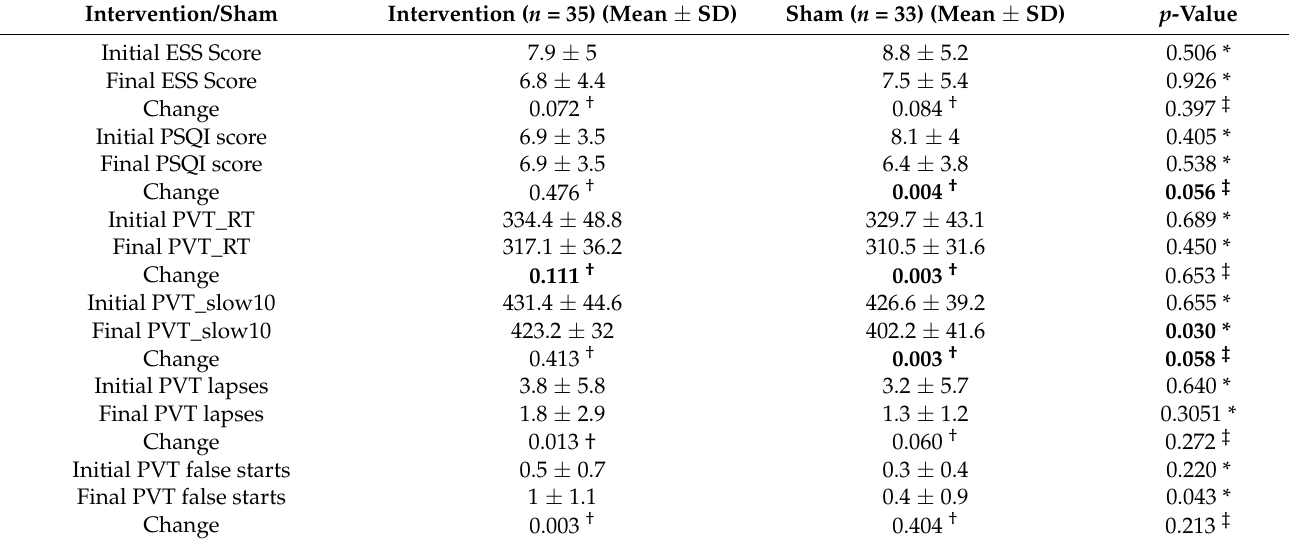
Table 4. Subjective sleep measurements and PVT (Psycho-motor Vigilance Test) results in intervention and Sham groups.